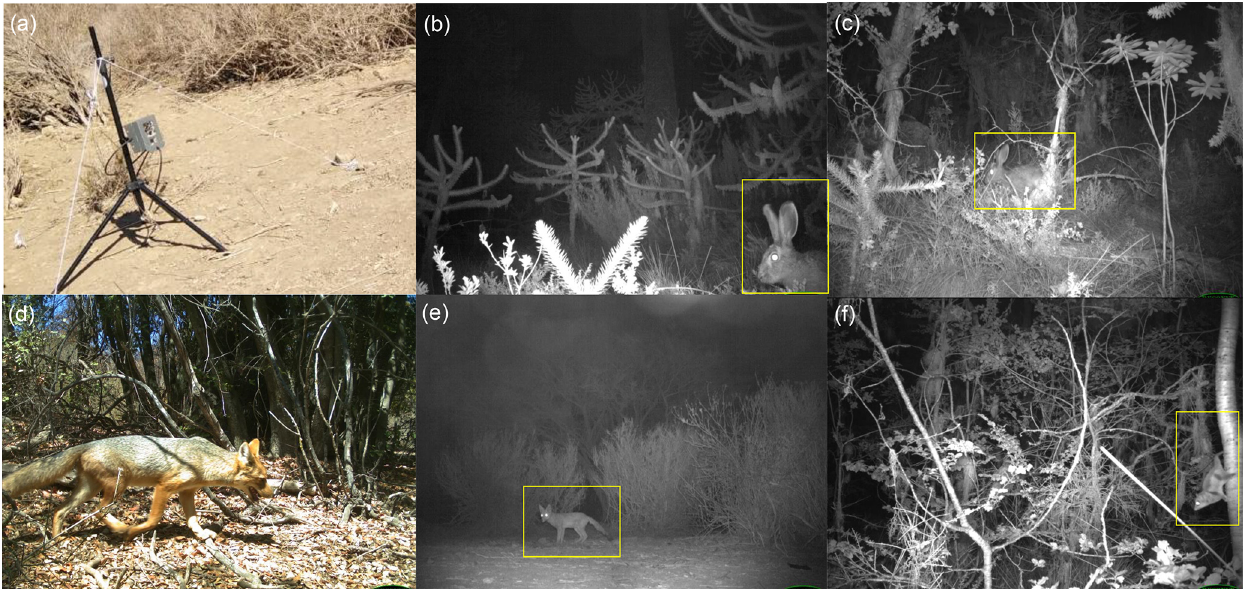
Figure 2. Examples of burrowing vertebrate animals recorded by motion-activated camera traps. (a) Setup of motion-activated camera trap. (b, c) European rabbit ( Oryctolagus cunniculus ). (d, e) Culpeo ( Lycalopex culpaeus ). (f) Bennett’s chinchilla rat (Abrocoma bennettii) . The yellow box highlights the position of the animal in the photo. Photo courtesy of Diana